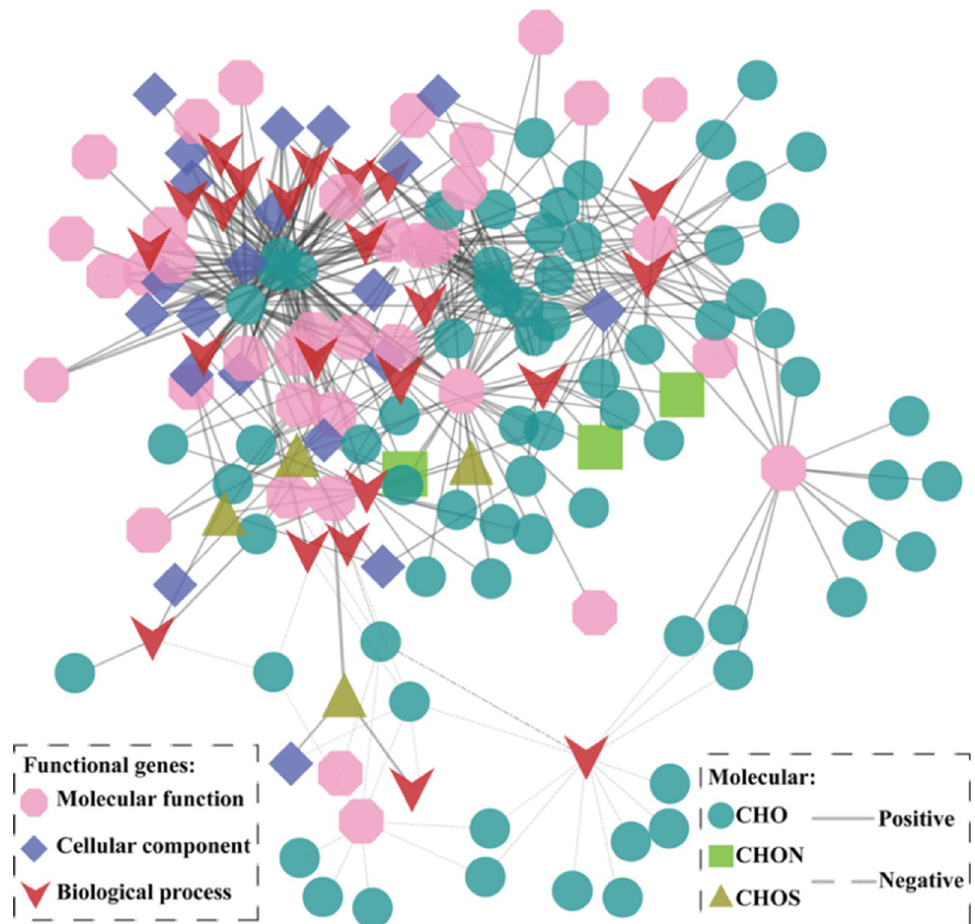
Fig. 5 Correlation analysis between BDOM molecular types and the top 100 functional genes of P. stutzeri and S.